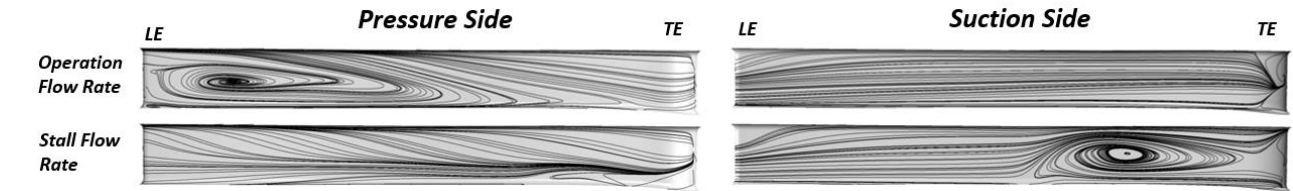
Figure 5. Flow fields in diffuser and EGV domains for different mass flow rates and spans.